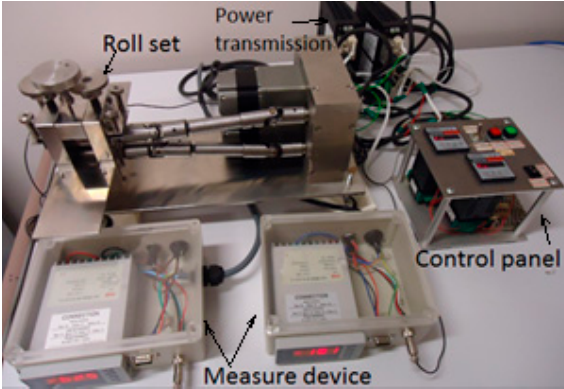
Figure 1. Micro-flat-rolling mill system (two-high). Table 1. Chemical composition of copper wire (not more than, wt %) [24].